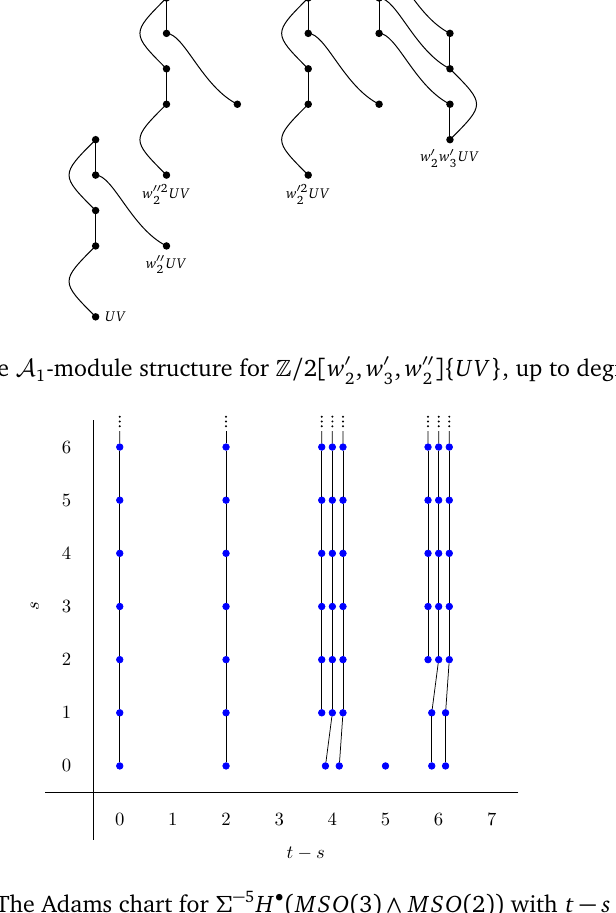
Figure 3: The Adams chart for Σ − 5 H • ( MSO ( 3 ) ∧ MSO ( 2 )) with t − s ≤